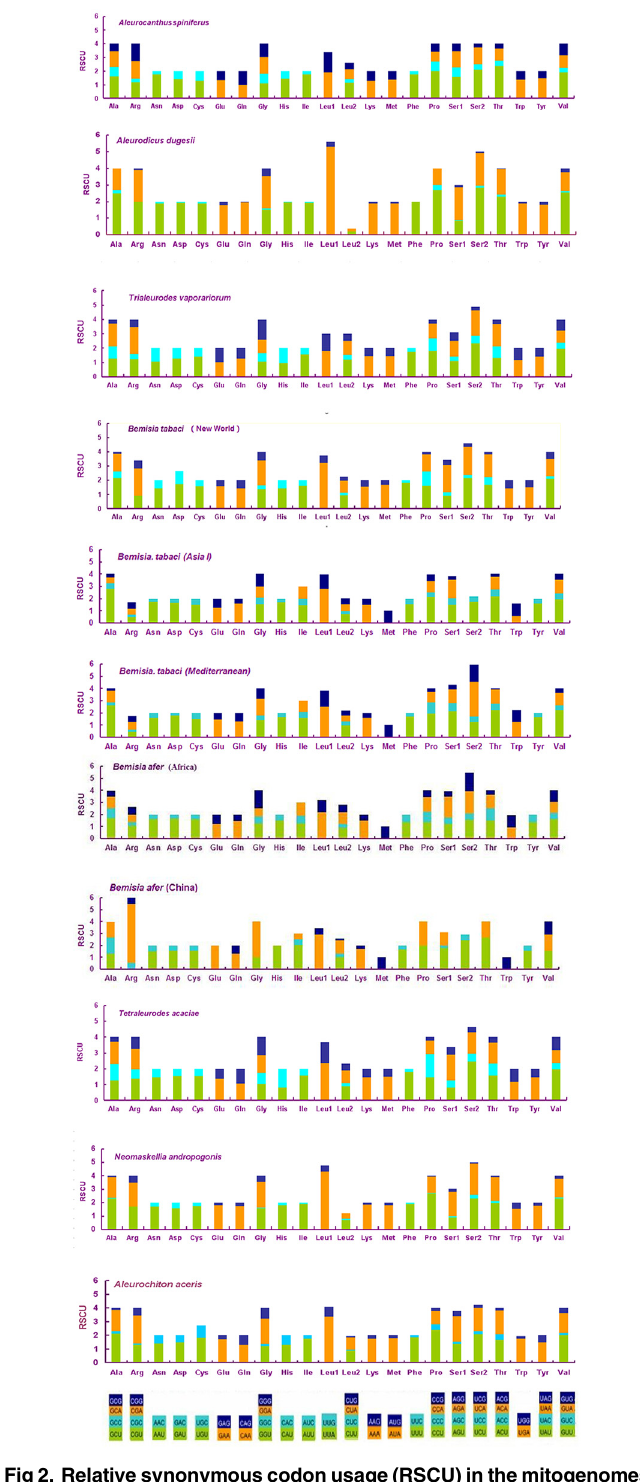
Fig 2. Relative synonymous codon usage (RSCU) in the mitogenomes of A . spiniferus and ten other species of Aleyrodidae. Codon families are given on the X-axis.